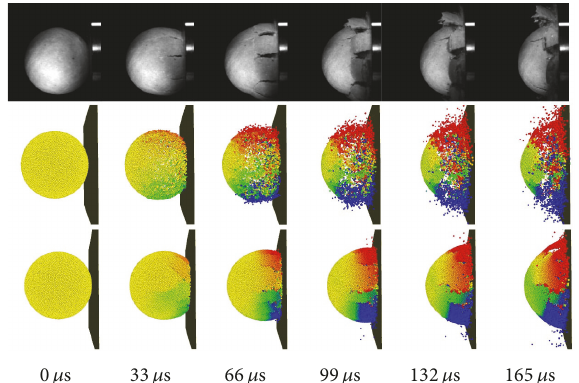
Figure 14: 𝐹(𝛿) curve with the broken discrete element counting during compression.